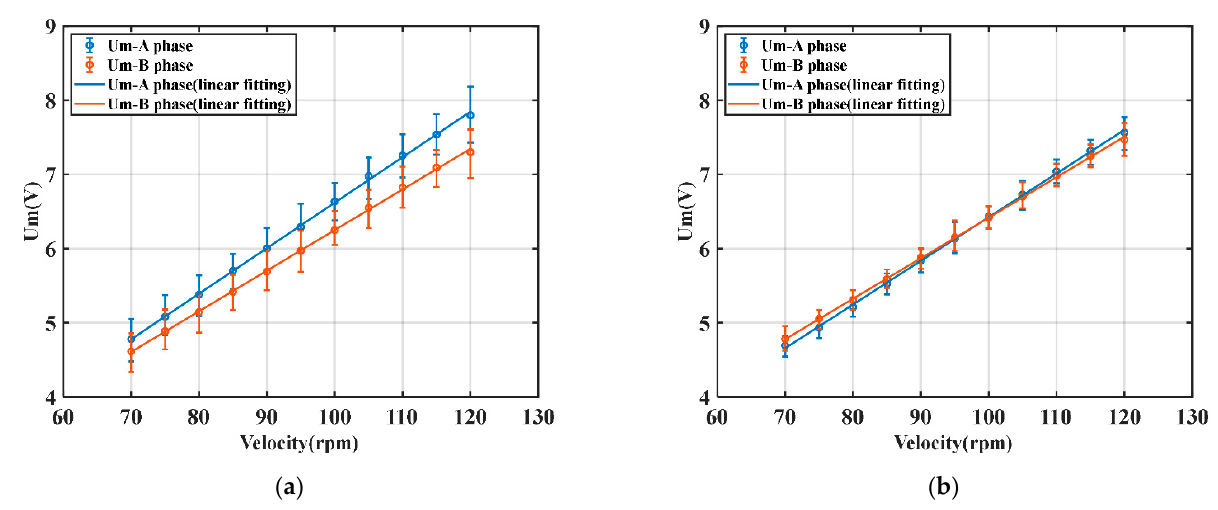
Figure 11. Stator vibration amplitude analyses: ( a ) relationship between velocity and SVA voltage in single-phase feedback VCBVF scheme; ( b ) relationship between velocity and SVA voltage in the proposed scheme.